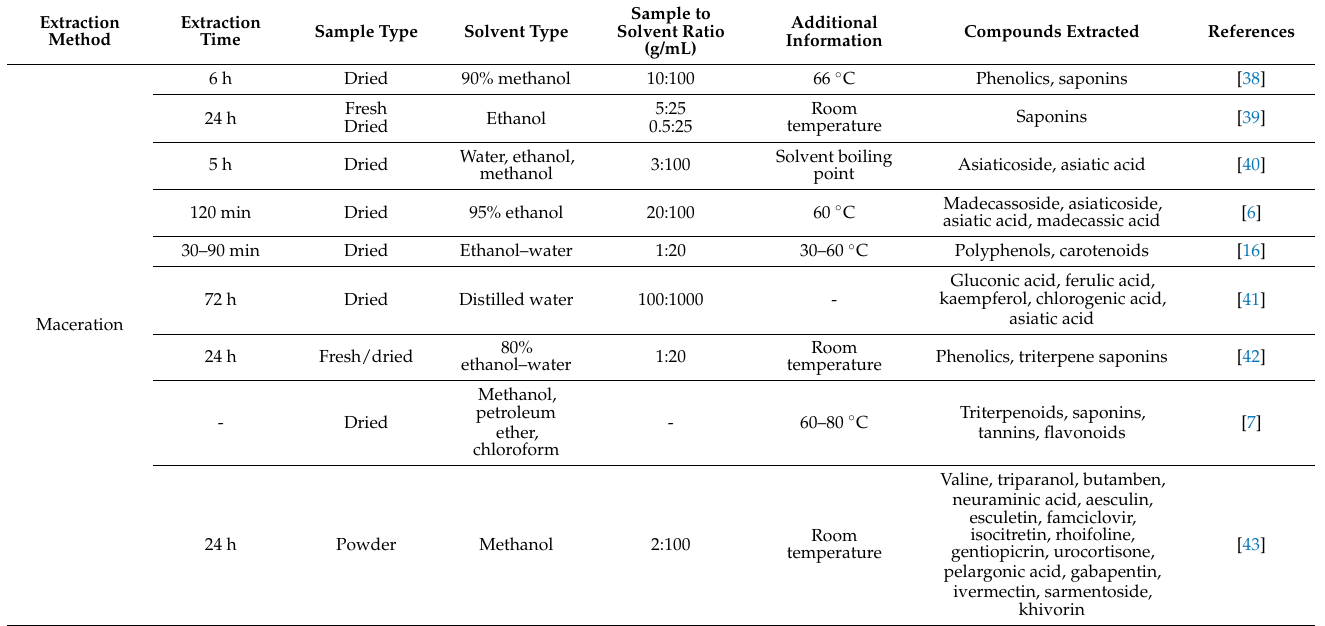
Table 1. Methods for the extraction of compounds in C.